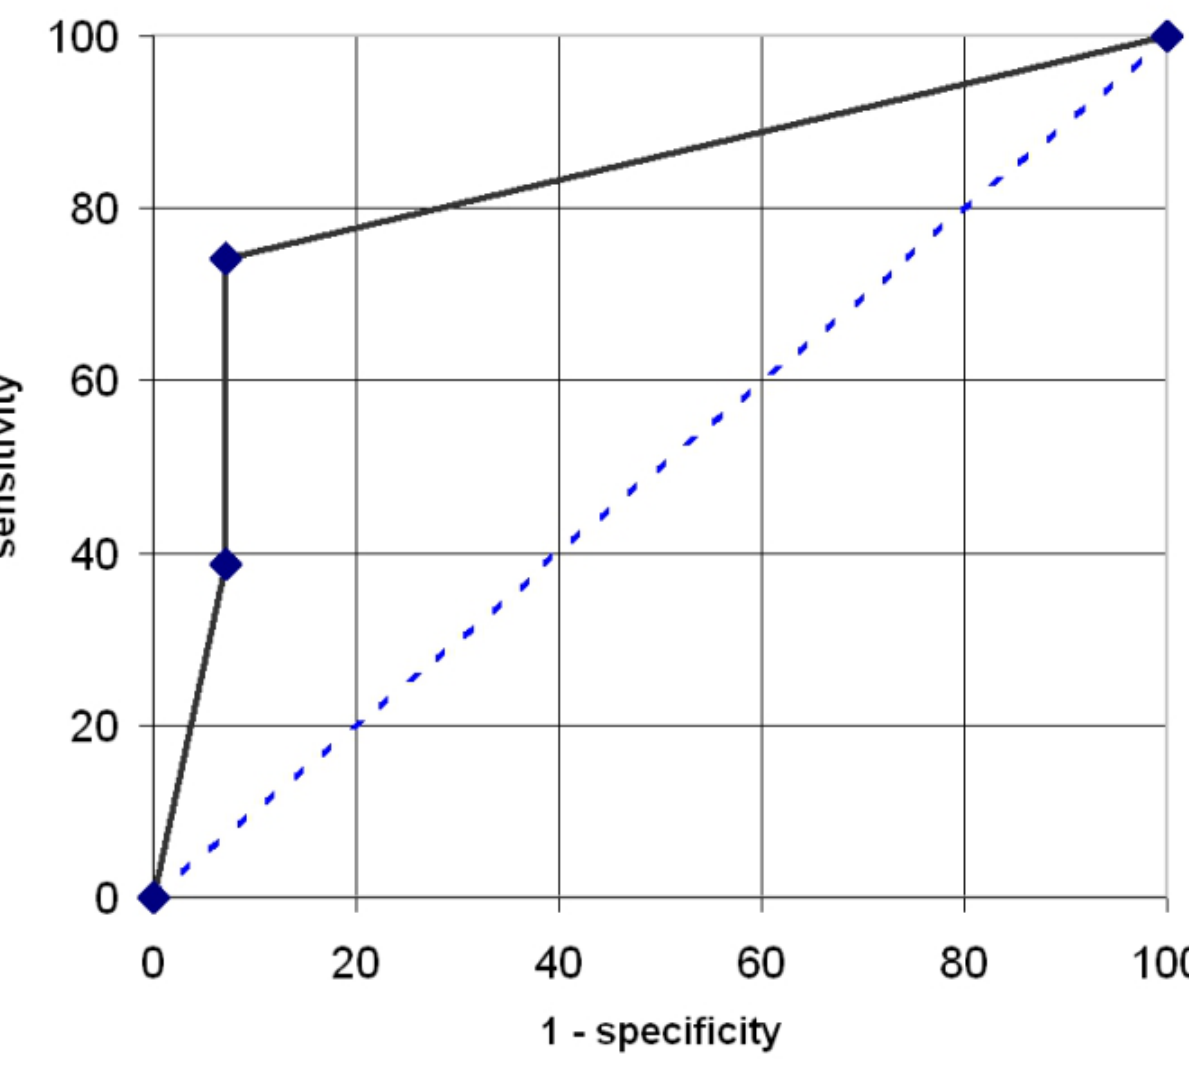
Fig. 4. A receiver operating characteristic (ROC) curve showing results of testing the classification success of the beta-level model in Fig. 3a with the case file data in Table 1. A ROC curve plots